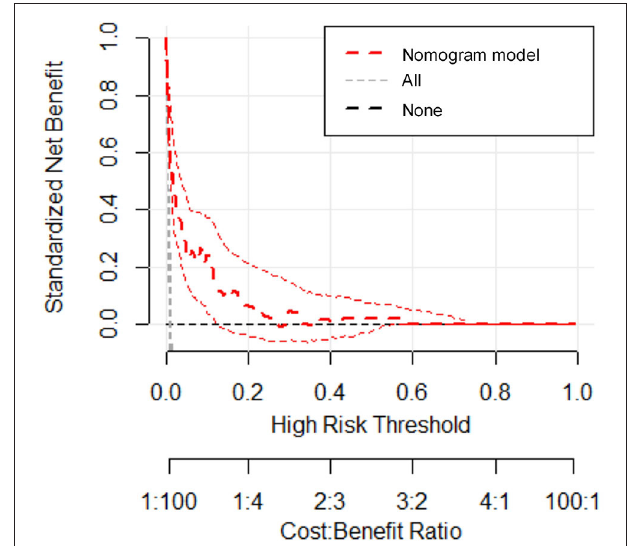
FIGURE 7 | Decision curve analysis for the prediction model. The red line represents the prediction model. The gray dashed line assumes all patients have early-onset PE. The horizontal line assumes no patients have early-onset PE. The red dotted line represents the expected net benefit per patient relative to the nomogram prediction of early-onset pre-eclampsia with 95% confidence